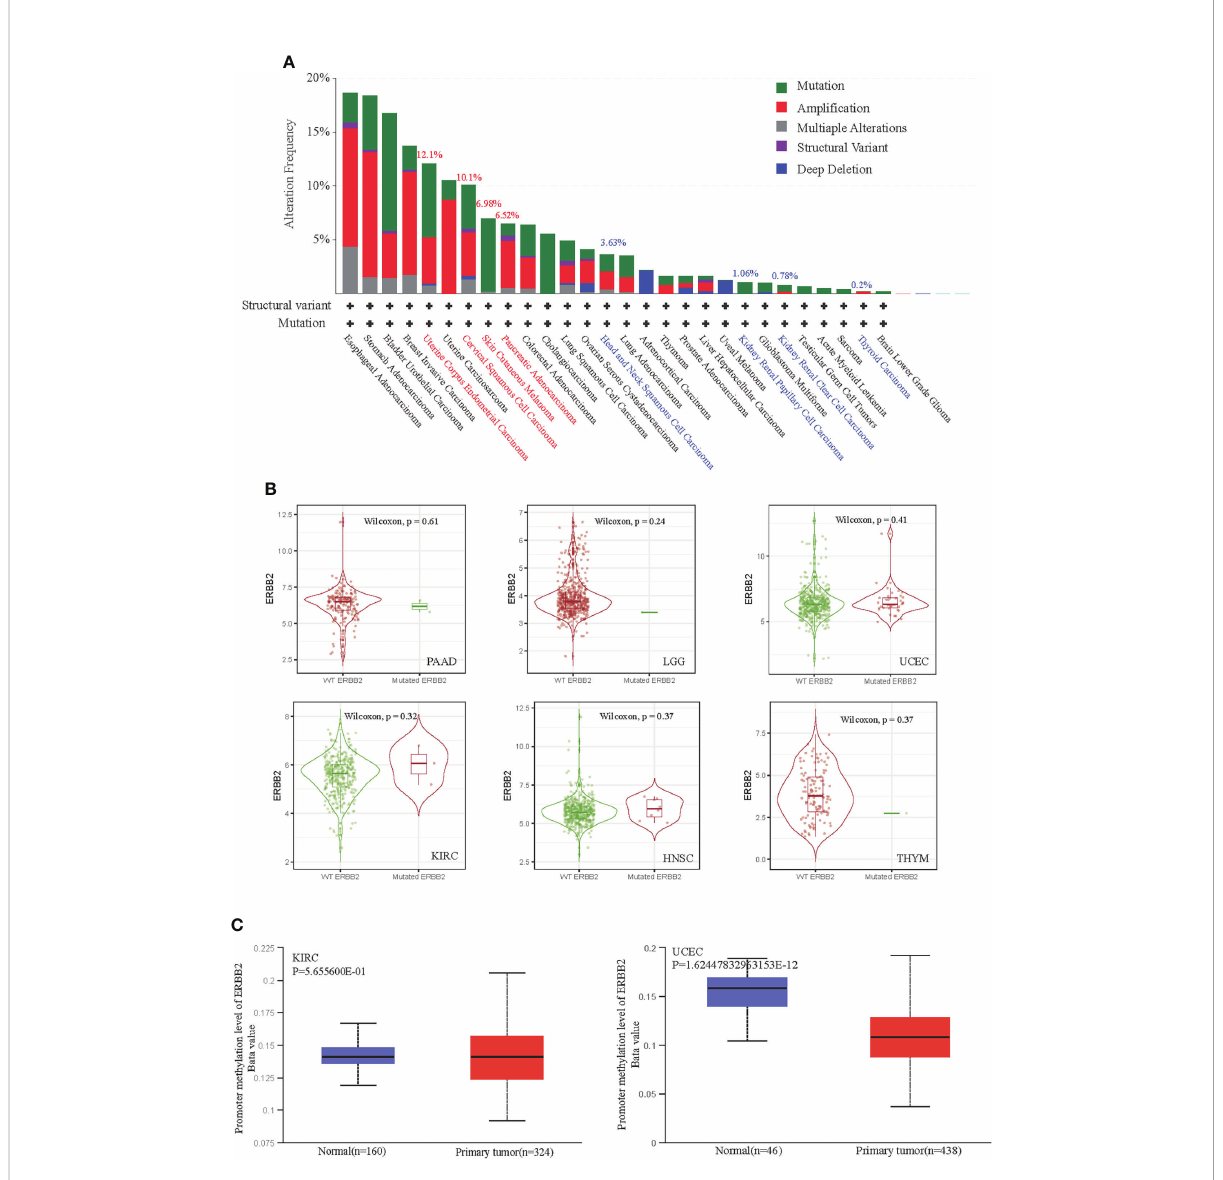
FIGURE 2 Correlation between ERBB2 gene promoter demethylation and gene mutation in TCGA database. (A) ERBB2 alteration frequency of 32 cancer categories is shown based on fi ltering. It is 12.1%, 10.1%, 6.98%, 6.52% alteration frequency of UCEC, CESE, SKCM, and PAAD; and 3.63%, 1.06%, 0.78%, 0.2% alteration frequency of HNSC, KIRC, KICH, THYM, respectively. (B) Mutation cases with biallelic pathogenic alterations of KIRC (n=367), HNSC(n=499), THYM(n=119), PAAD (n=170), LGG(n=511), and UCEC(n=528) are not signi fi cant (P>0.05; Wilcoxon rank-sum test) compared with their wild-type cases. (C) The level of DNA promoter methylation, ranging from 0 (unmethylated) to 1 (fully methylated). Different deta cut-off value was considered to indicate lower-methylation(Beta value:down to 0.25) or hypo-methylation (Beta-value: 0.3 - 0.25). The normal group of KIRC and UCEC showed lower methylation. However, the primary tumor group of UCEC showed signi fi cant